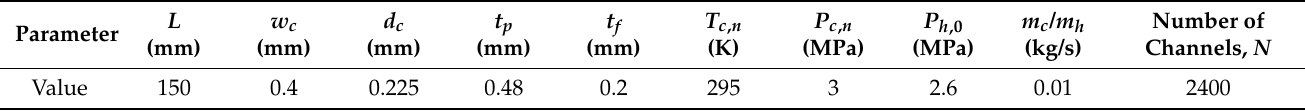
Table 4. Experimental parameters of PCHE.